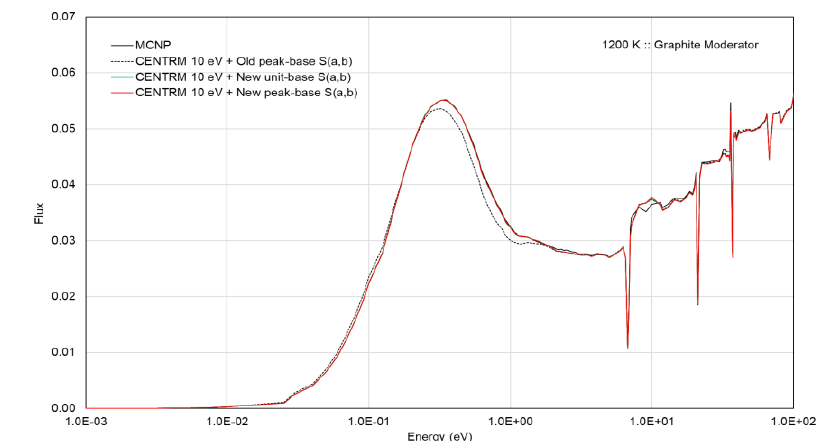
Figure 4. Comparison of CENTRM and MCNP thermal neutron spectra.